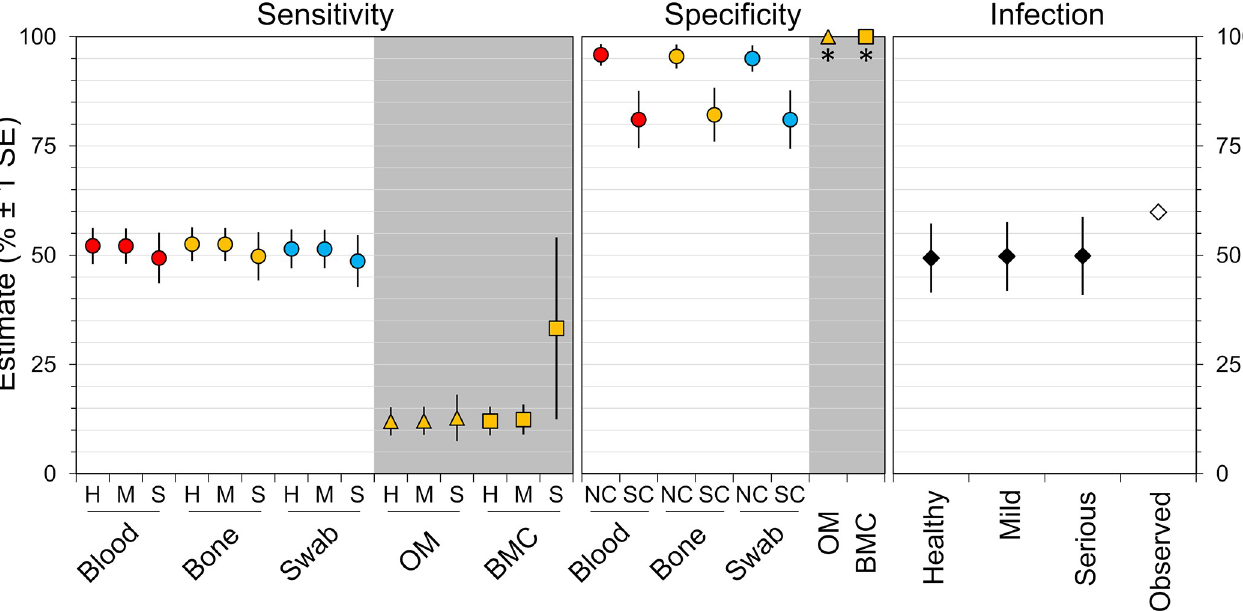
Fig 4 presents model-averaged estimates of DP clinical sensitivity and specificity, along with Leishmania infection-frequency estimates, derived from the full, 40-model set; error bars